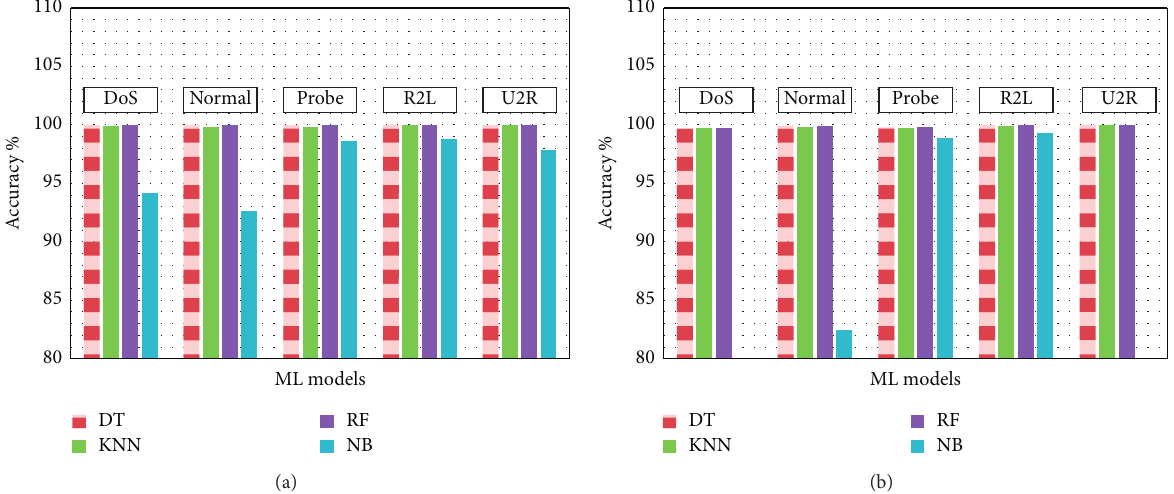
Figure 6: The results of machine learning testing performance for KDD dataset: (a) accuracy using all features and (b) accuracy using selected features.